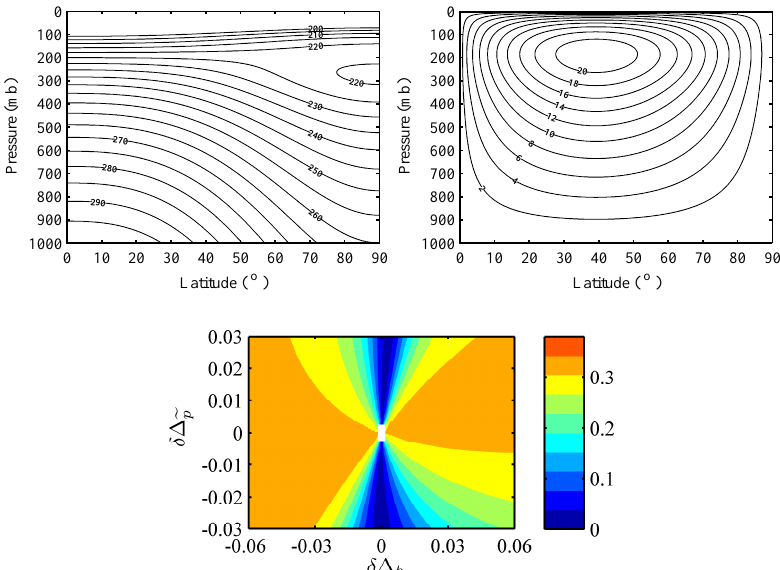
Figure 4. Balanced (a) temperature (K) and (b) zonal wind (ms − 1 ) in the 2-D thermal wind model. (c) Ratio of the non-dimensional kinetic to enthalpy components of separation-squared when (cid:49) h and (cid:49)